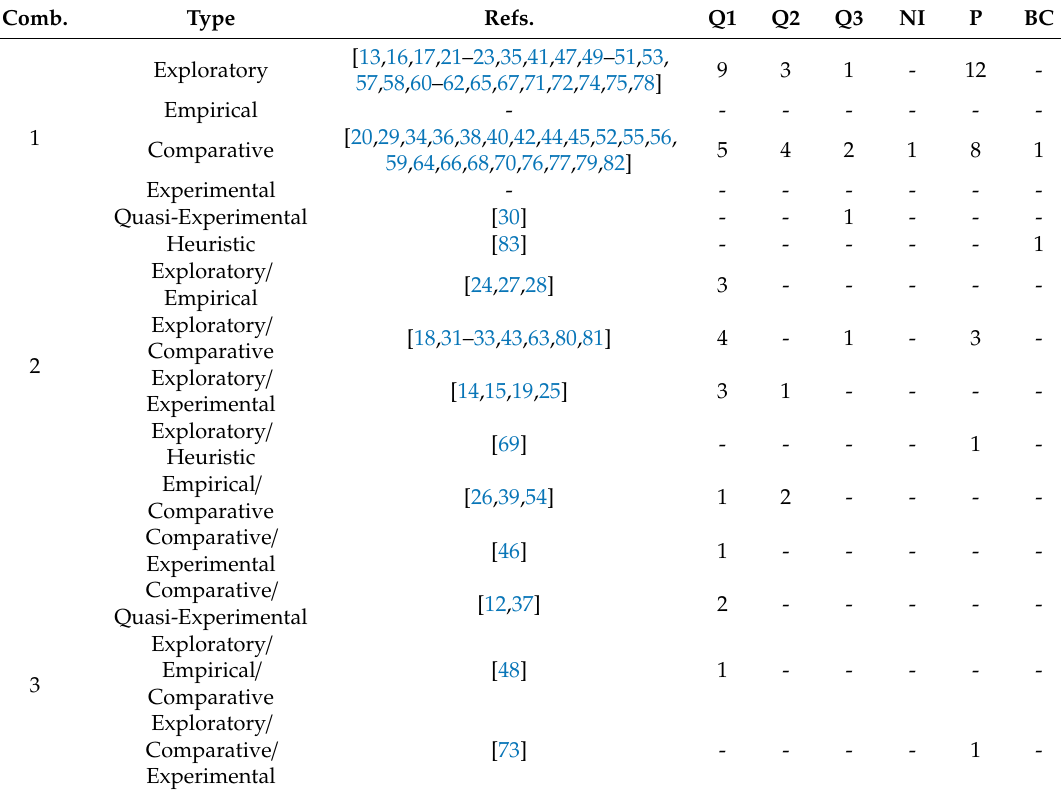
Table 7. Combination of research